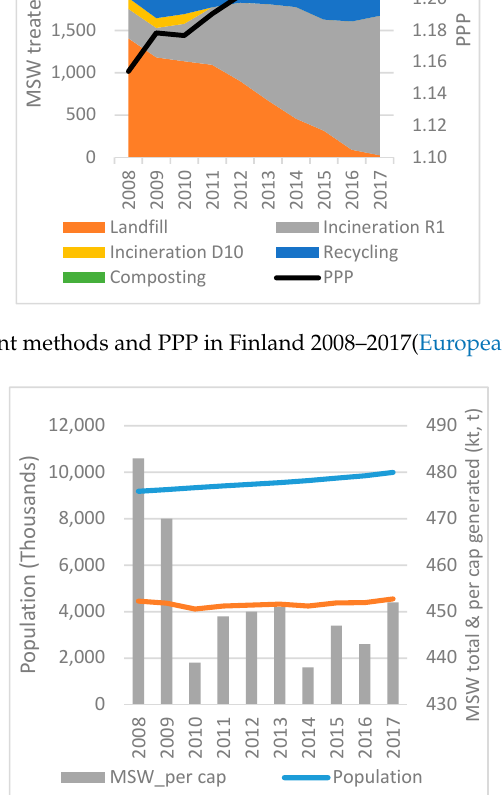
Figure 52. Waste treatment methods and PPP in Finland 2008–2017(EUROSTAT 2019b, 2019c).